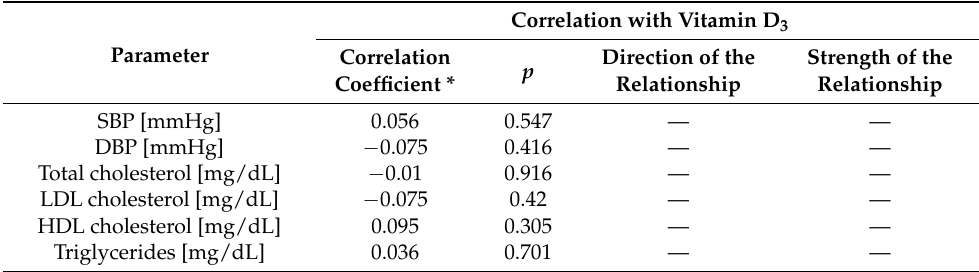
Table 4. Analysis of the correlation between the women’s age and vitamin D 3 levels. Correlation p Direction of the Relationship Variables Coefficient * Age and vitamin both variables move in the same 0.298 0.001 D 3 levels direction (positive correlation)